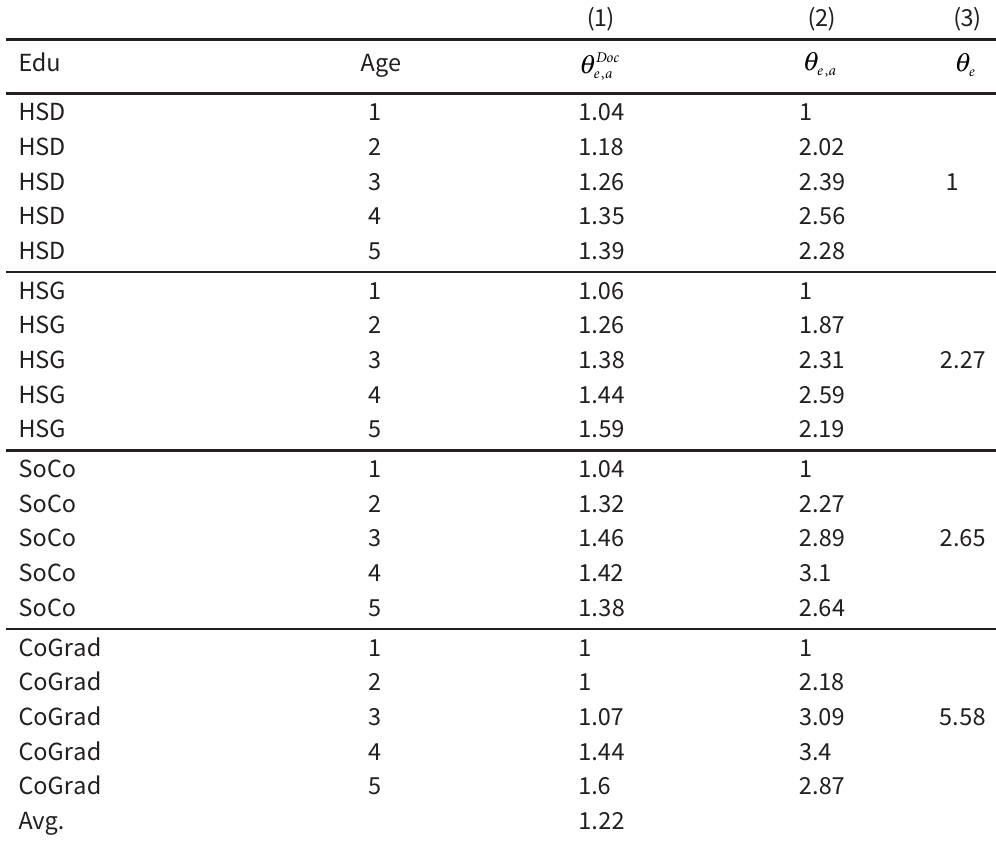
Calibration Productivity